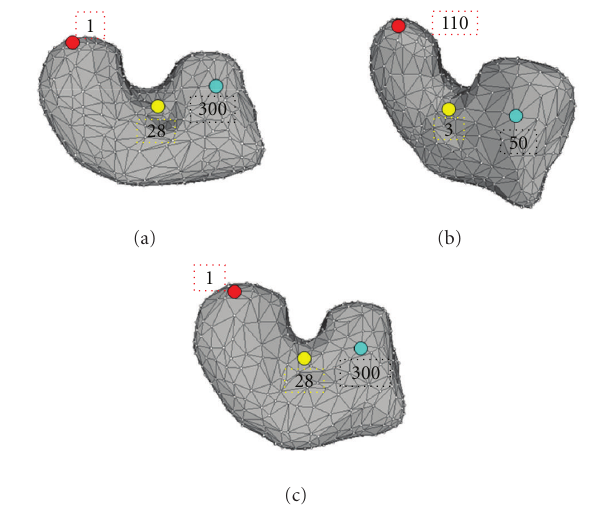
Figure 3: Surface correspondence: (a) vertex index on deformation 1, (b) vertex index on deformation 2 before correspondance, (c) corresponding vertex index on deformation